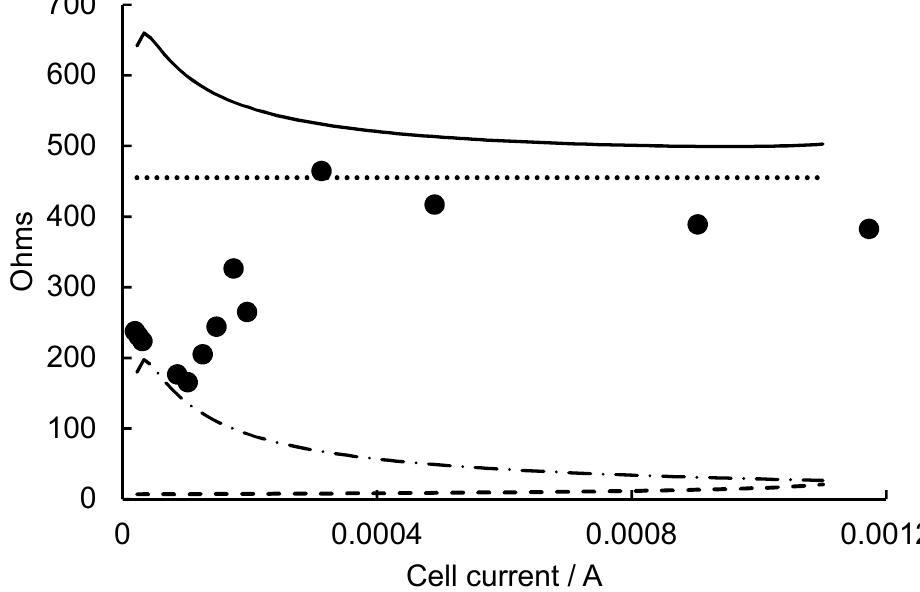
Figure 4. Variation of SMFC resistances at pH 6: experimental R i ( • ) and the predictions of R i (solid line), R act (dashed dotted line), R conc (dashed line), and R ohmic (dotted line).